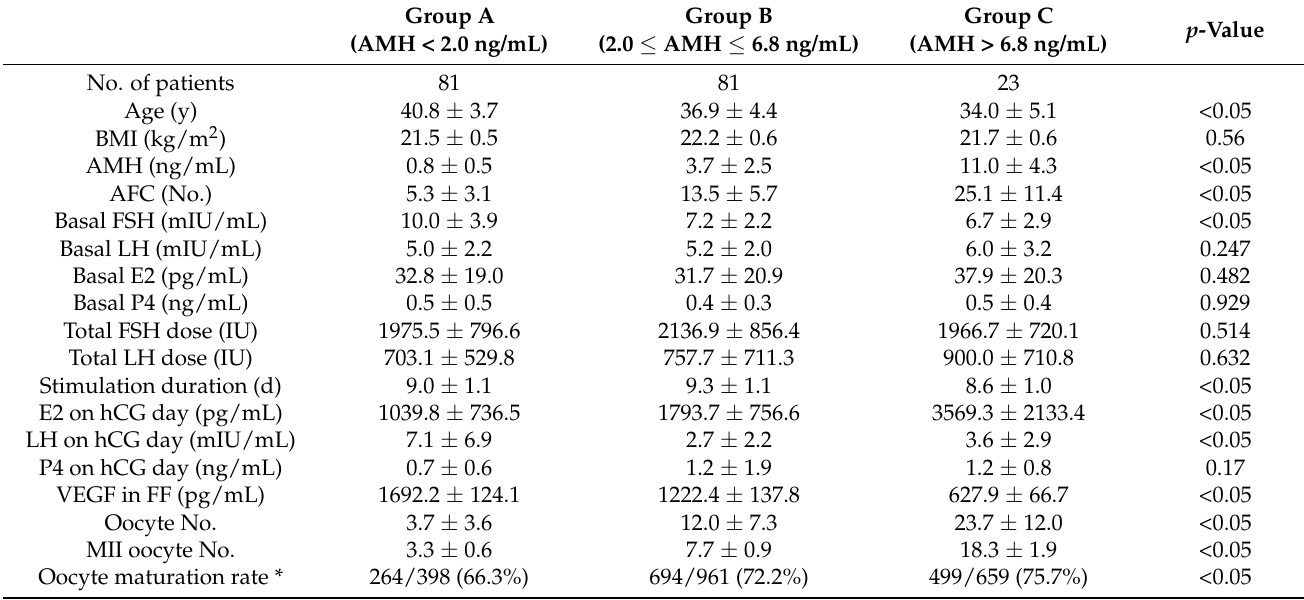
Table 1. Baseline characteristics and laboratory measurements in different ovarian reserve groups.